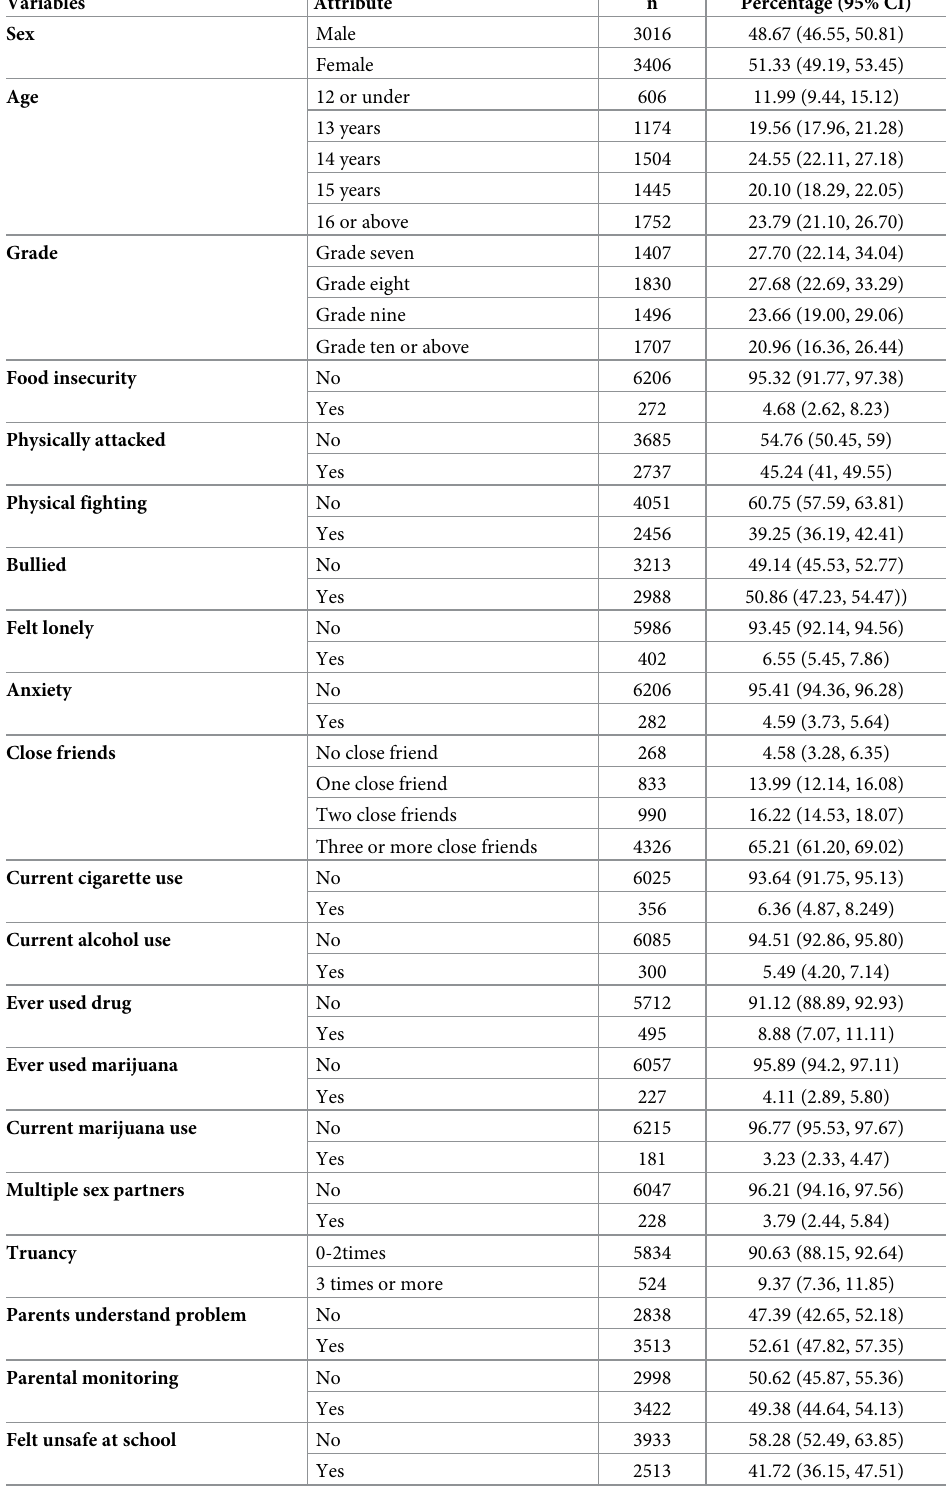
Table 1. Characteristics of research